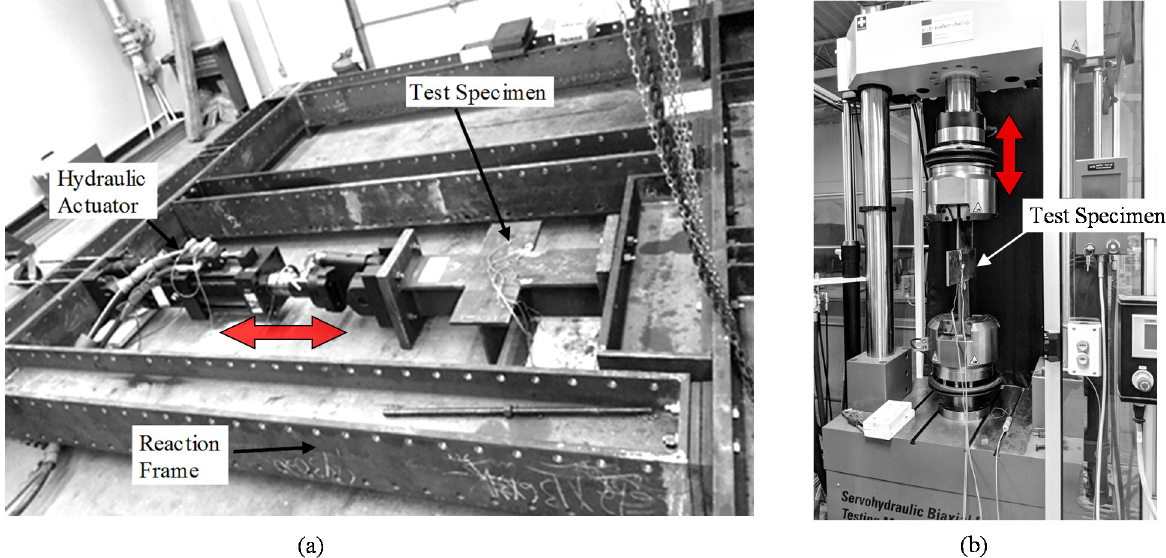
Figure 28. Photograph of the experimental setup for ( a ) full-scale testing in the large reaction frame and ( b ) half-scale testing in the Walter + Bai servo-hydraulic biaxial fatigue testing machine. Table 7. Experimental test matrix.